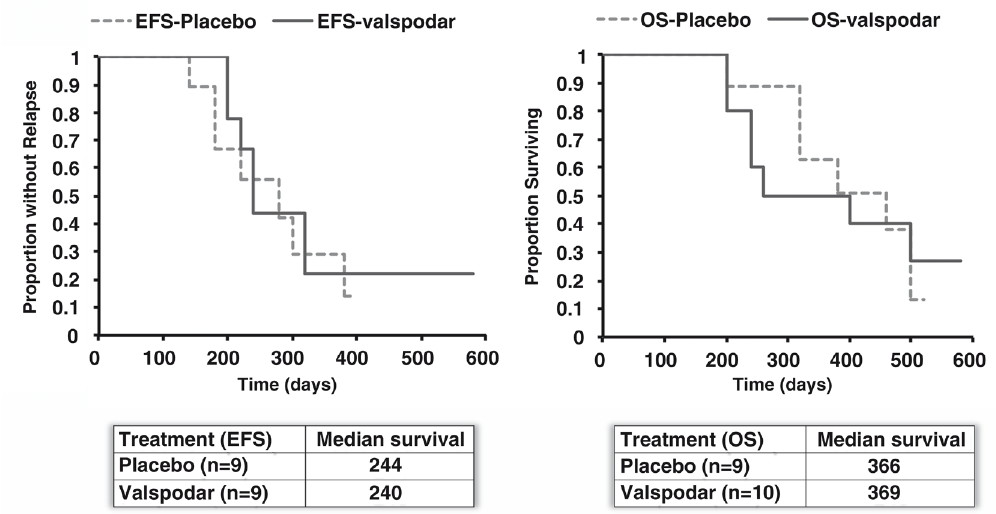
Figure 6. Effect of neoadjuvant valspodar on survival of dogs with large B-cell lymphoma. Kaplan–Meier analysis of event-free survival (top) and overall survival (bottom) in dogs treated with doxorubicin with the addition of neoadjuvant placebo or valspodar. The table below the graphs shows the median event-free and overall survival for each group. Data were analyzed and graphs were assembled using MS Excel.